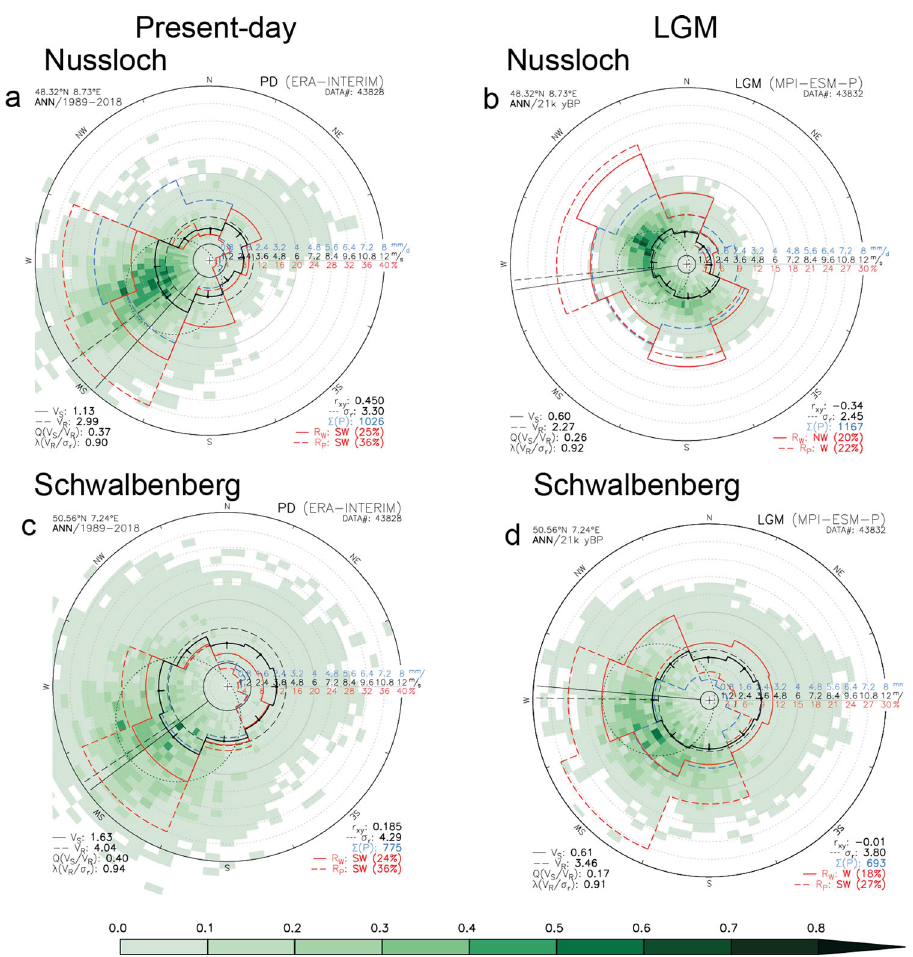
Fig. 6 Annual wind regime and precipitation statistics. The models are obtained for present day and LGM conditions at Nussloch ( a , b ) and Schwalbenberg ( c , d ). Shaded area presents the average precipitation fl ux at given wind direction/strength (percent of total). Sector line plots show wind speed (black), wind occurrence (red solid), precipitation rate (blue dashed) and total precipitation (red dashed, normalized) distribution about rhumbs. Thin solid/long-dashed line circles visualize the scalar/absolute winds and their directions, respectively; thin-dashed circle shows wind vector. SD. Note that wind direction is meteorological (from where wind blows). Further statistics tabled: V S and V R − absolute and scalar wind speed [m/s], R w and R p − rhumbs of maximum wind and precipitation occurrence [percent], Q − wind steadiness ( V S / V R ratio), r xy − wind zonal and meridional components correlation, σ r − wind vector SD [m/s], λ − wind absolute speed to SD ratio, Σ ( P ): total annual precipitation